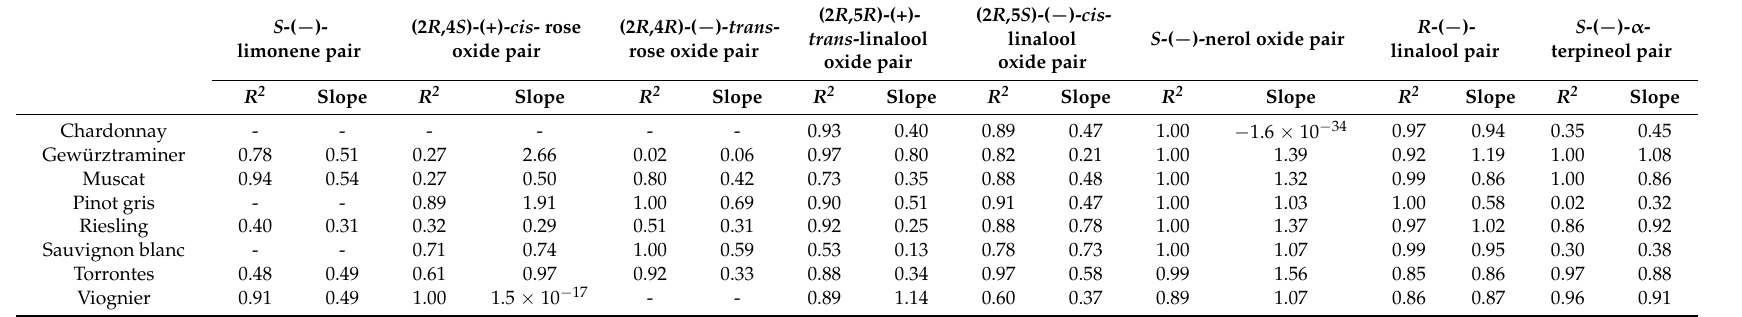
Table 4. The R 2 value and slope for the fitted line in the X-Y scatterplots of Figure